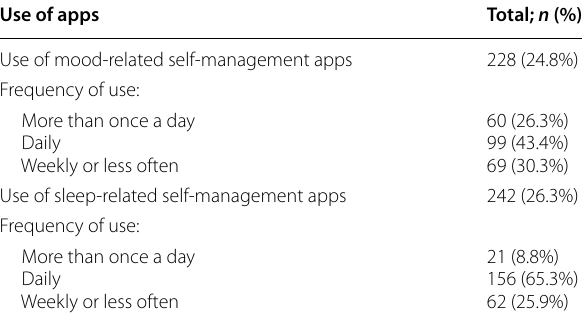
Table 2 Use of BD-related apps Use of